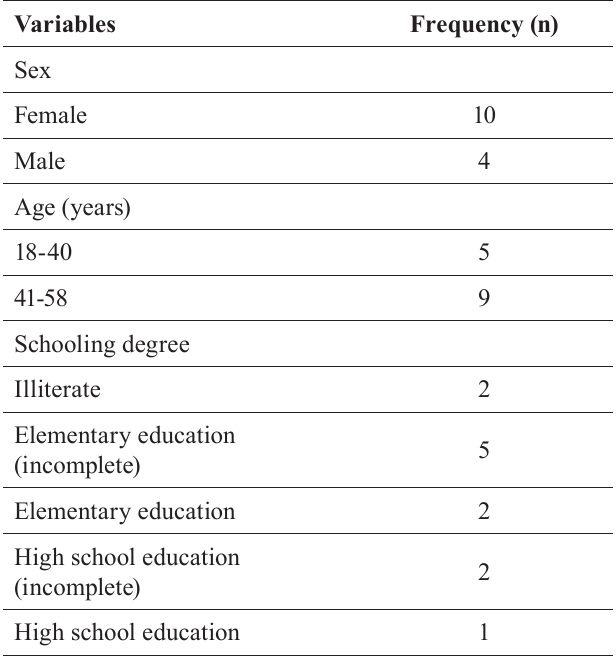
TABLE I - P atients sociodemographic data (n=14)